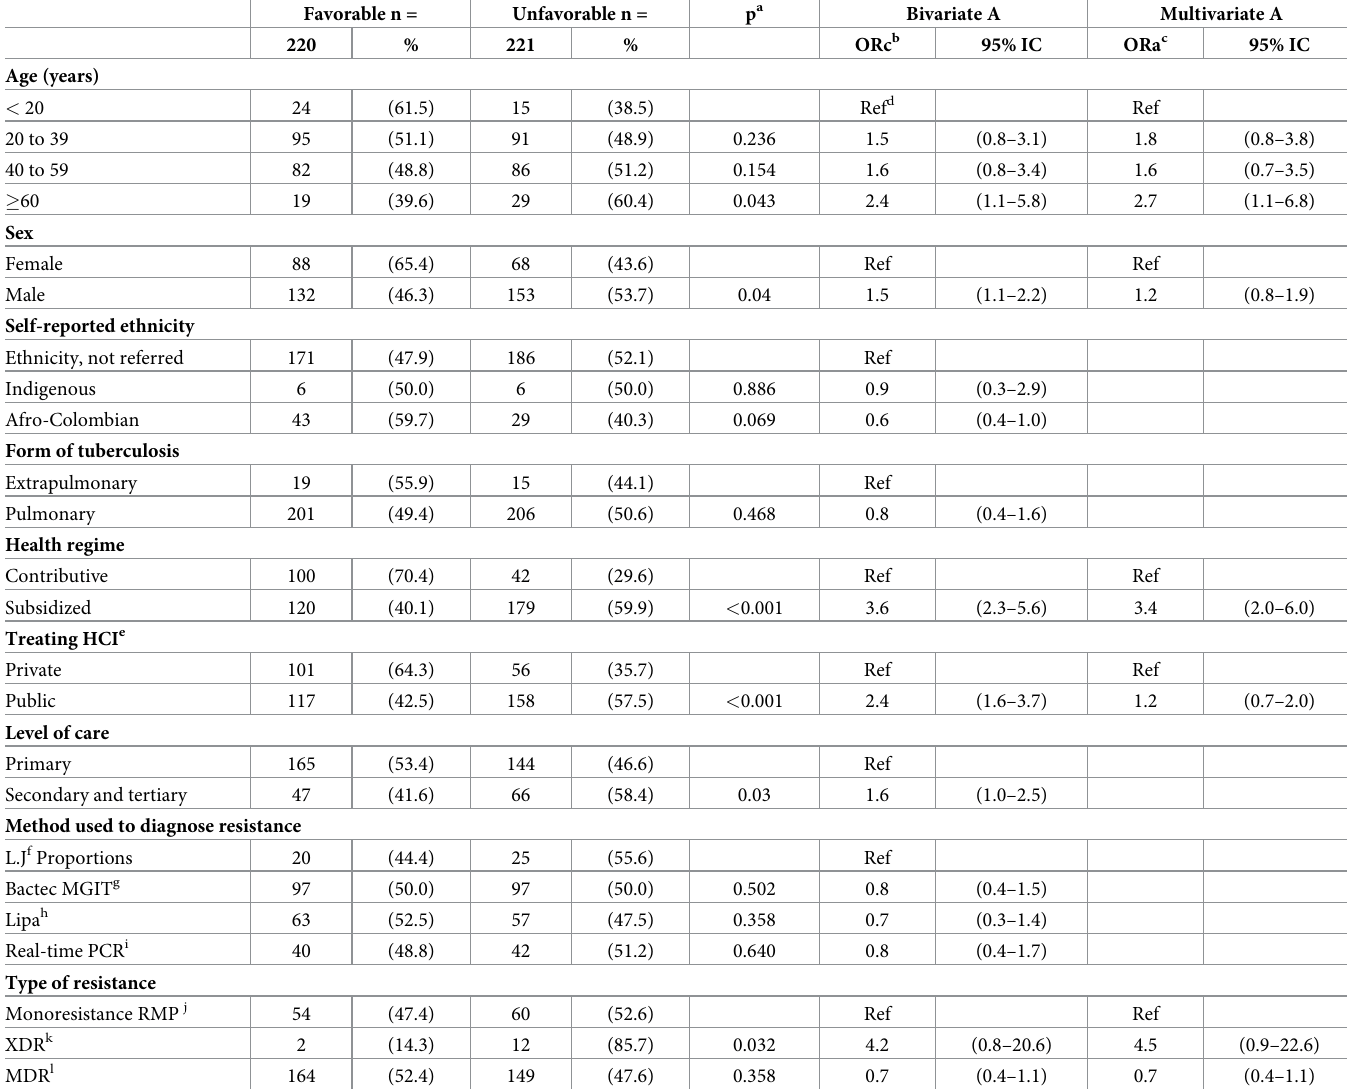
Table 1. Sociodemographic, clinical, and laboratory characteristics and treatment outcomes of patients in the MDR/RR-TB cohort in Colombia,